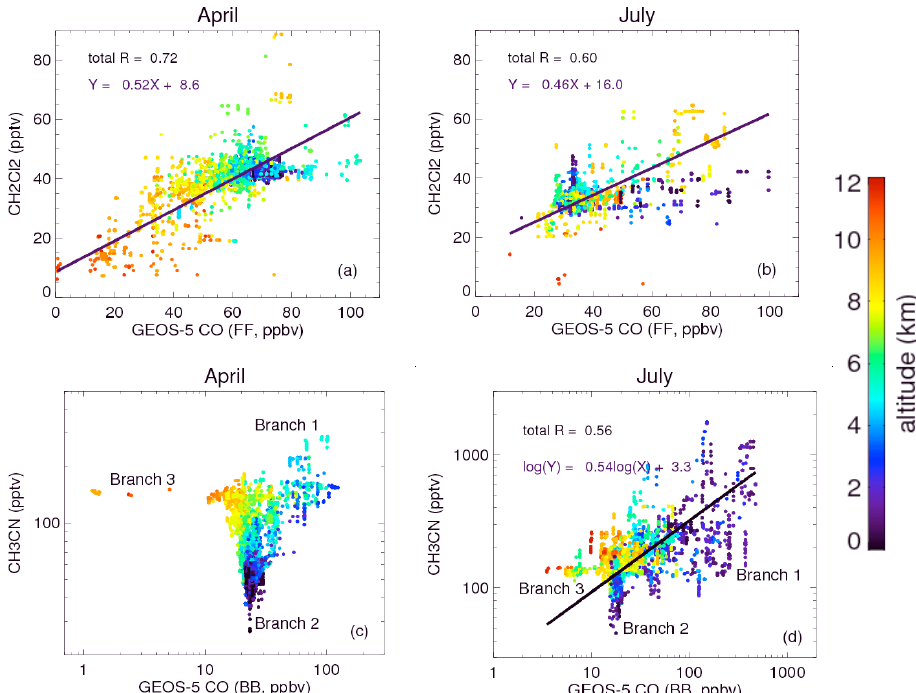
Figure 4. Top: Scatter plots of observed CH 2 Cl 2 (pptv) and modeled fossil fuel tagged Bottom : Scatter plots of Fig. 4. Top: scatter plots of observed CH 2 Cl 2 (pptv) and modeled fossil fuel tagged CO (ppbv) from Asia, North America, and Europe in CH 3 CN (pptv) and modeled biomass burning tagged CO (ppbv) from boreal and non-­‐ April (a) and July (b) . Bottom: scatter plots of observed CH 3 CN (pptv) and modeled biomass burning tagged CO (ppbv) from boreal and April (c) and July (d). The results are colored according to the measurement altitudes. Each point non-boreal regions in April (c) and July (d) . The results are colored according to the measurement altitudes. Each point represents median represents median values of model results and observations within 10 minutes. values of model results and observations within from Asia, North America, and Europe in April (a) and July (b).